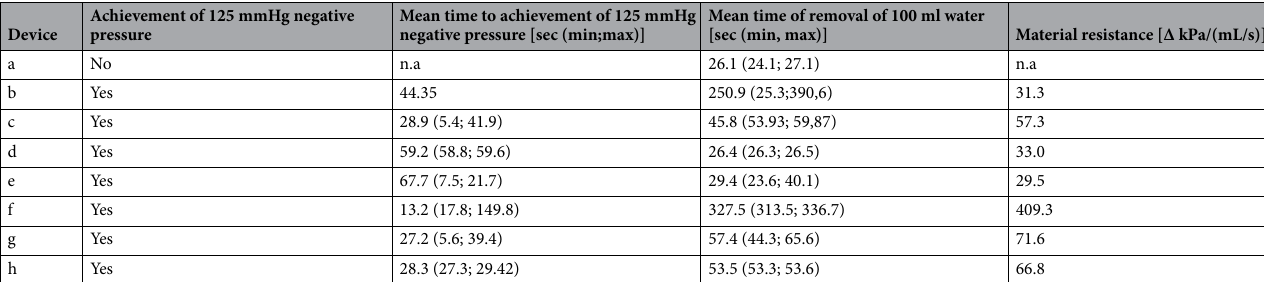
Table 1. Results of measurements according to the tubes and devices for endoscopic negative pressure therapy of the upper gastrointestinal